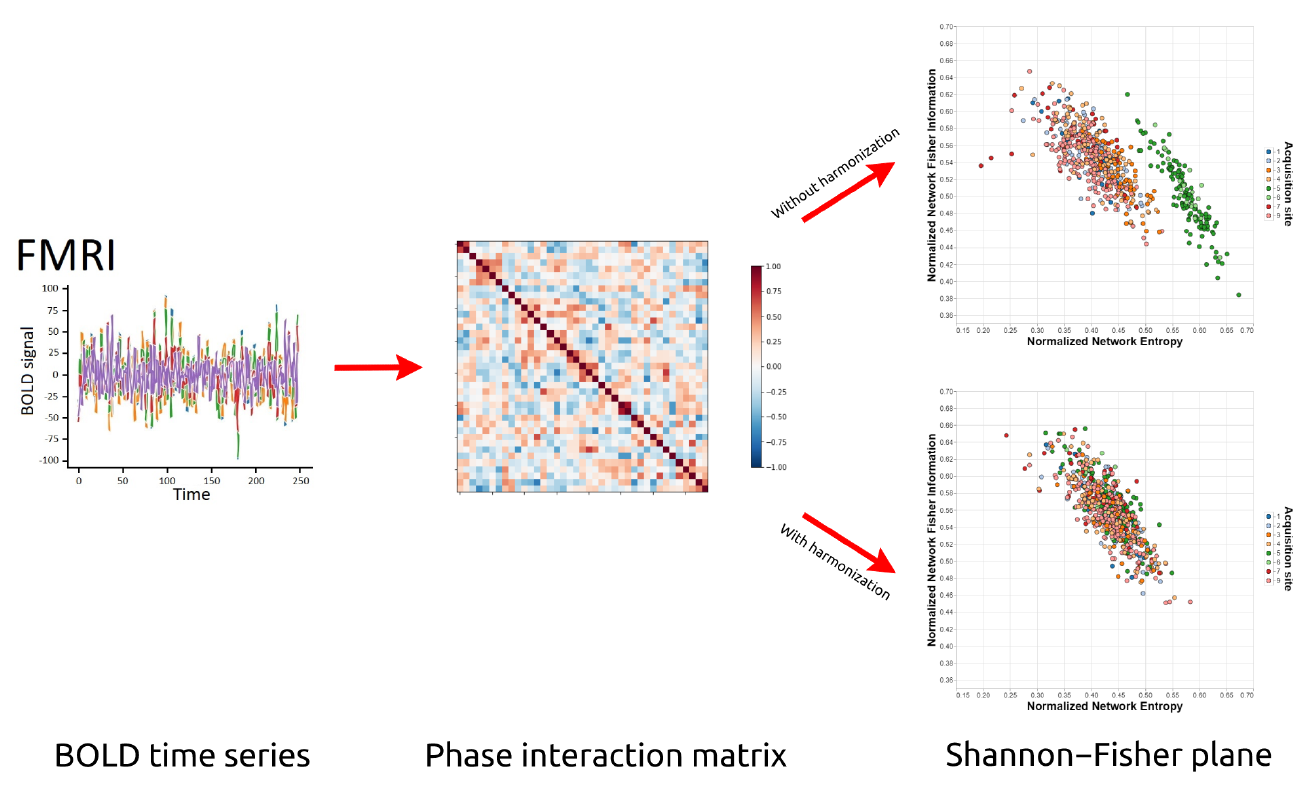
Figure 1. Overview of our technique to analyze, with the help of Information Theory, the effectiveness of the harmonization techniques for multi-site acquired data. From a set of multi-site fMRI data, we generate the Phase Interaction Matrix and, from there, we verify in the Shannon–Fisher plane the quality of the application of different harmonization